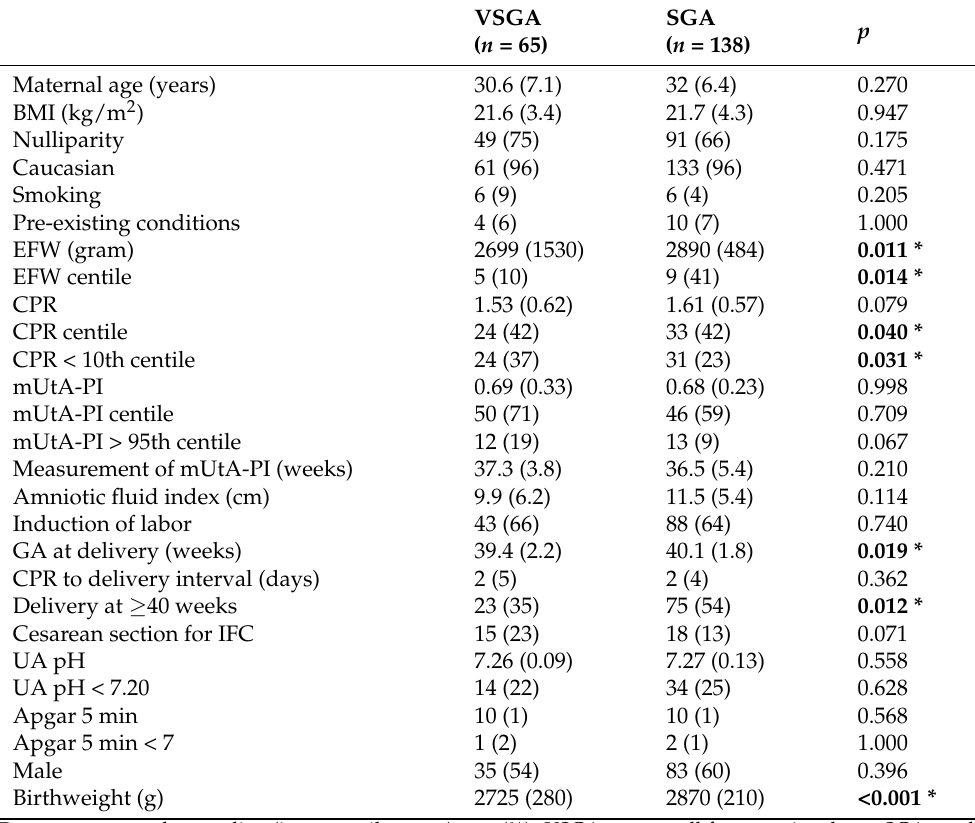
Table 1. Characteristics and outcomes of the study population according to birth weight.